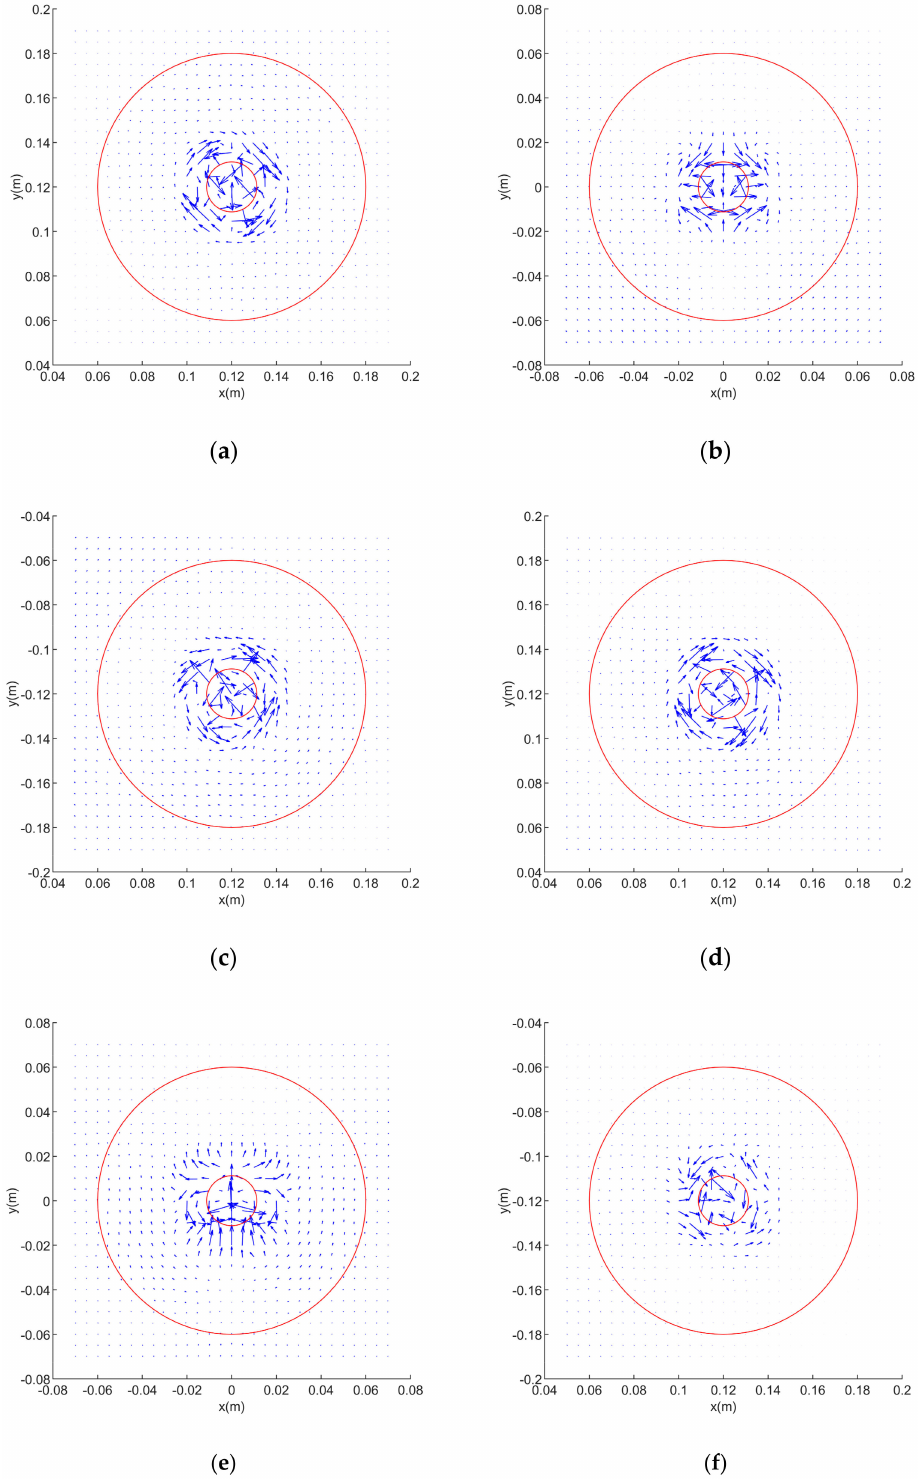
Figure A3. Power flow transmission graphs at an excitation frequency of 1100 Hz in x–y plane: ( a ) ABH(i) with BC 1, ( b ) ABH(ii) with BC 1, ( c ) ABH(iii) with BC 1, ( d ) ABH(i) with BC 2, ( e ) ABH(ii) with BC 2, ( f ) ABH(iii) with BC